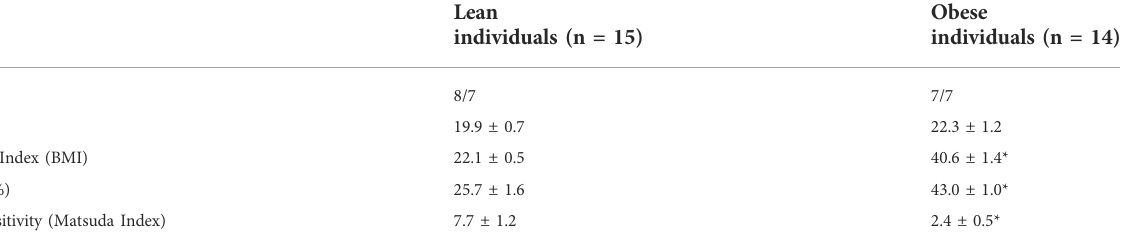
Lean individuals (n =